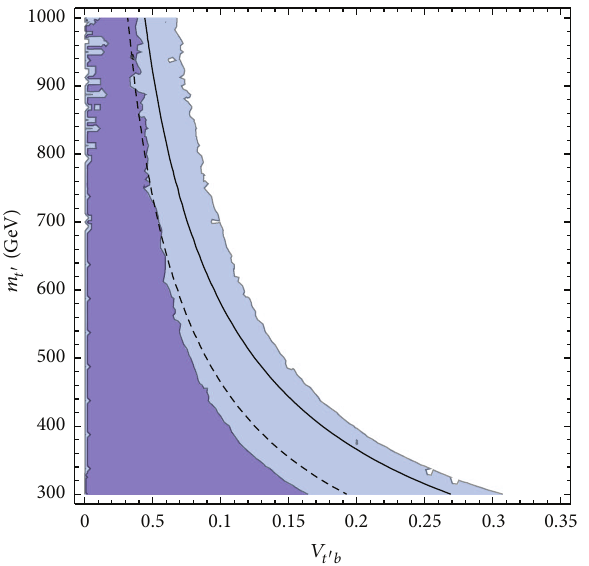
Figure 2: Reproduction of the 𝜒 2 fit of the oblique parameters 𝑆 and 𝑇 as given from Figure 2 in [11], considering a chiral fourth generation quark 𝑡 󸀠 . The upper limits at 68% (darker blue) and 95% (lighter blue) CL on the 𝑡 󸀠 mass are depicted as a function of the CKM mixing |𝑉 𝑡 󸀠 𝑏 | , freely varied over [300,800] GeV/ 𝑐 2 and [0,0.3] , respectively. The solid (dashed) curve denotes the upper bound (|𝑉 |) under which 𝑡 󸀠 𝑡 󸀠 and 𝑡 󸀠 𝑞 ( 𝑡 󸀠 𝑞 ) bound states can form, as 𝑚 𝑡 󸀠 𝑡 󸀠 𝑏 defined by relation